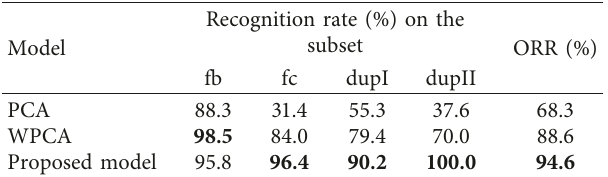
Table 1: Comparison results of different learning methods with LBP features.